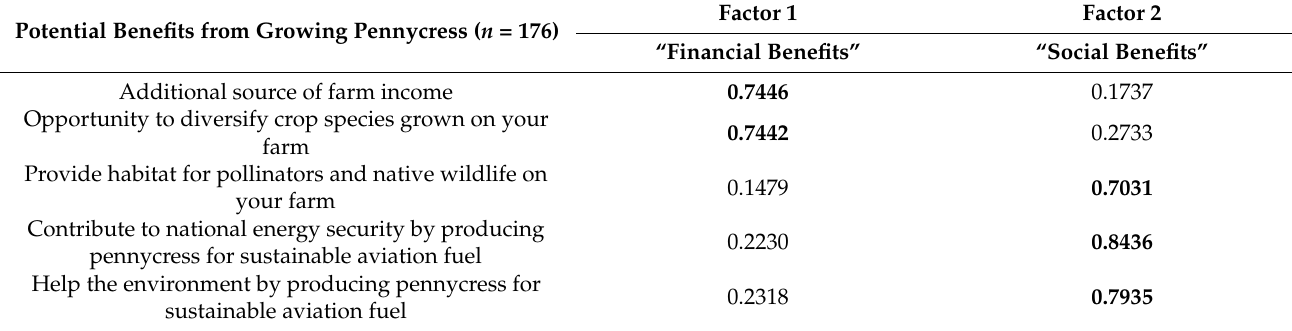
Table 4. Factor loadings for importance of benefits on decision to grow pennycress among crop farmers surveyed in seven US